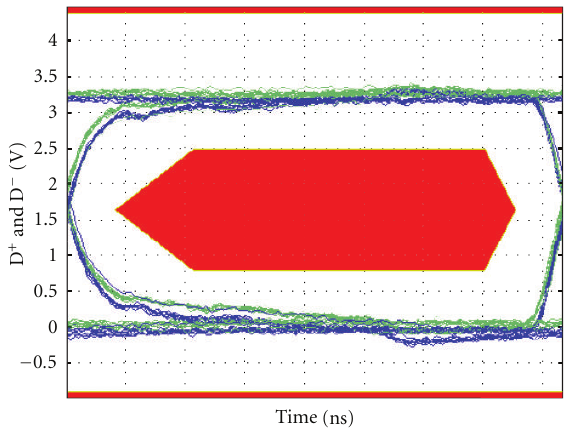
Figure 33: Measurement results from EYE pattern of fabricated PHY. The results meet the USB 2.0 specifications.